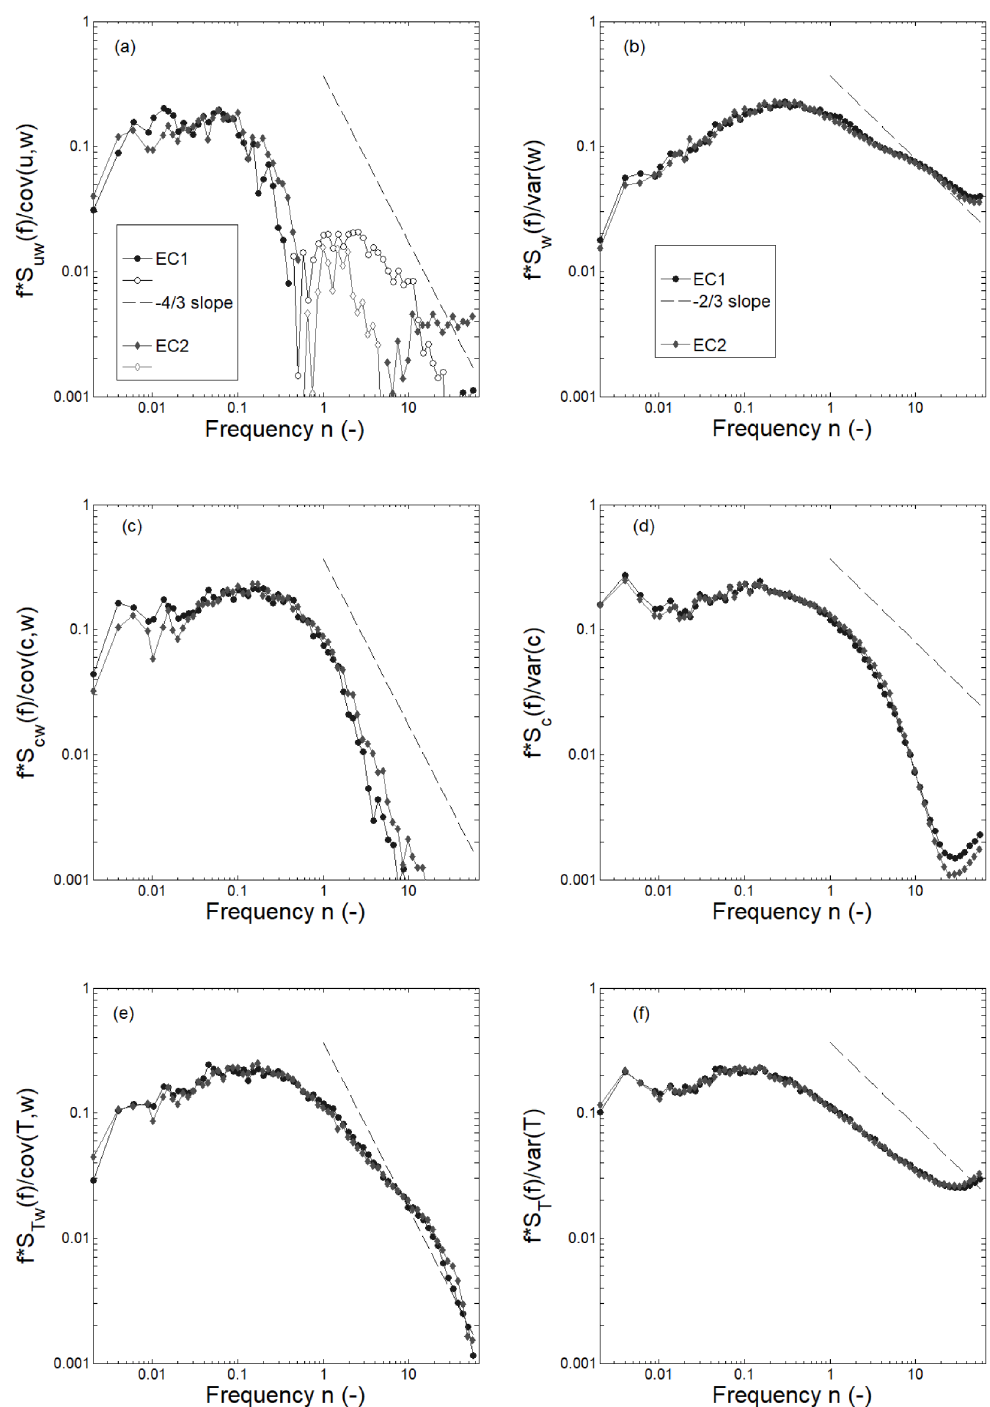
Figure 10. Cospectra (a, c, e) and spectra (b, d, e) of wind ( u and w component, respectively), CO 2 concentration and air temperature ( T ) as measured with the two EC systems for the undisturbed wind directions during July 2014 (2 . 5 < U < 4ms − 1 , solar radiation > 10Wm − 2 ). Solid symbols indicate positive and open symbols indicate negative contributions of the particular normalised frequency n ( n = f (z − d)/U ). The − 4 / 3 and − 2 / 3 slopes are those predicted by